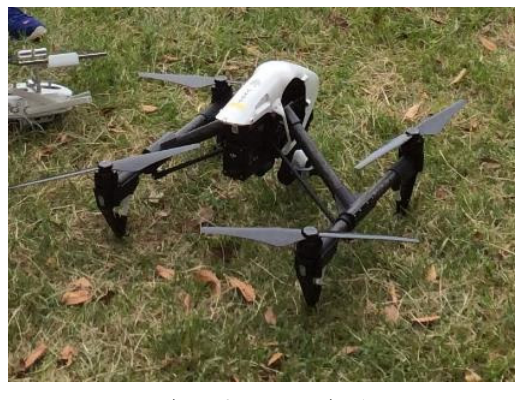
Figure 3. DJI Inspire